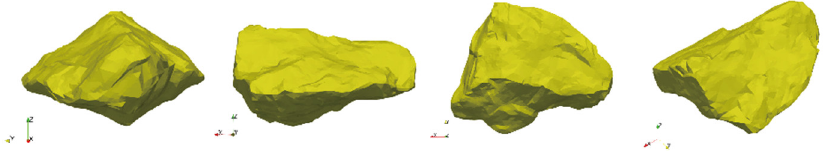
Figure 2. Shape model of the debris in the simulations.